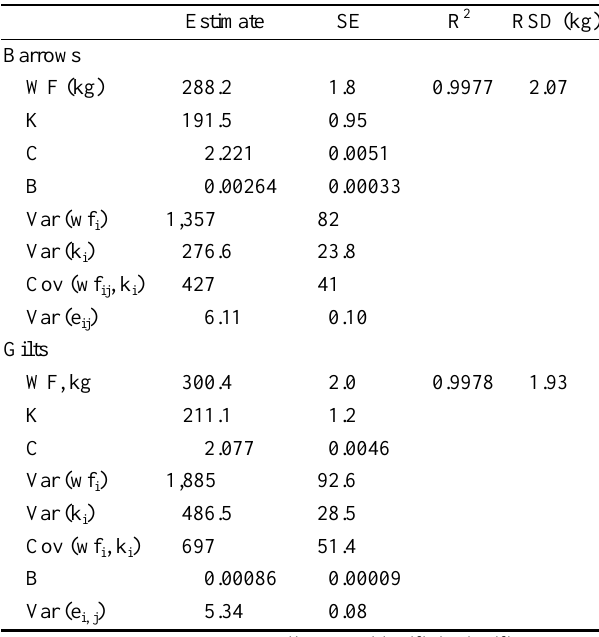
Table 5. Parameters and statistics for the generalized Michaelis- Menten function fitted to the BW data